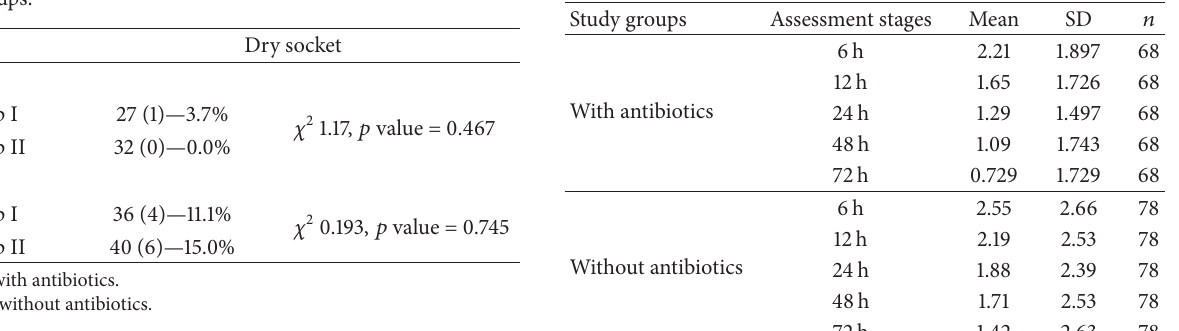
Table 3: Mean distribution of postoperative pain in both groups.